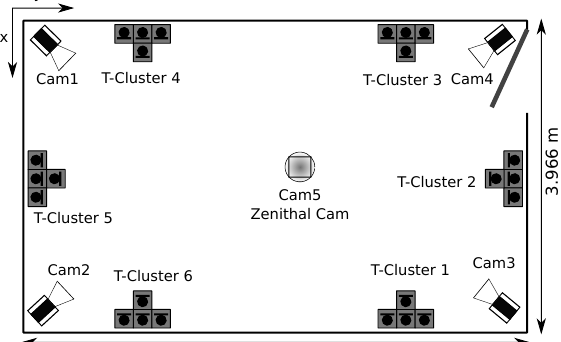
Figure 2. Smart-room sensor setup used in this database, with 5 cameras (Cam1-Cam5) and 6 T-shaped microphone clusters (T-Cluster 1